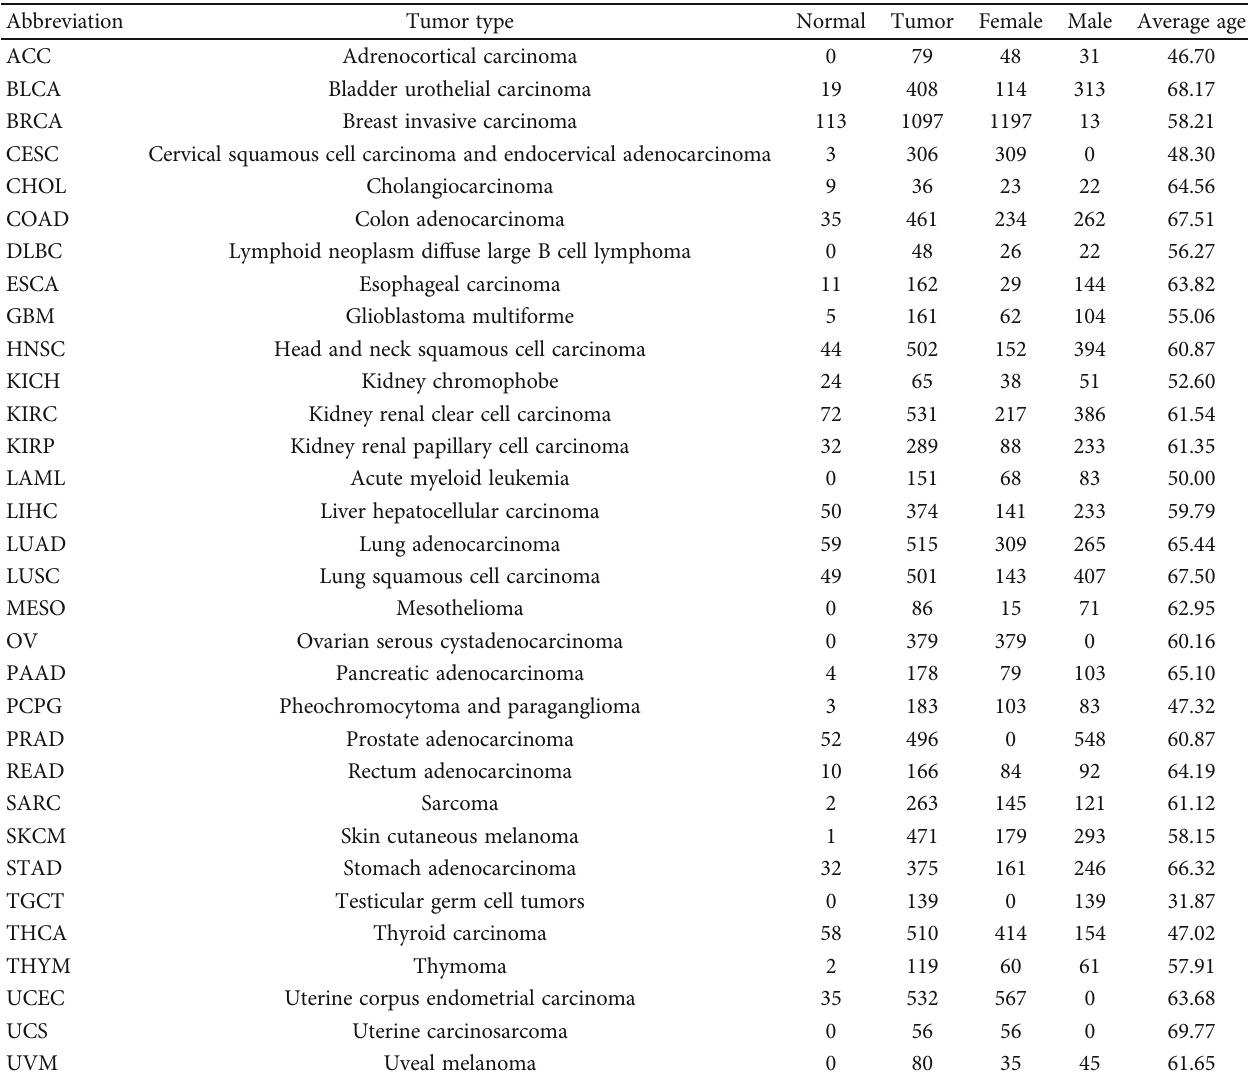
Table 1: Clinical features of pan-cancer from TCGA